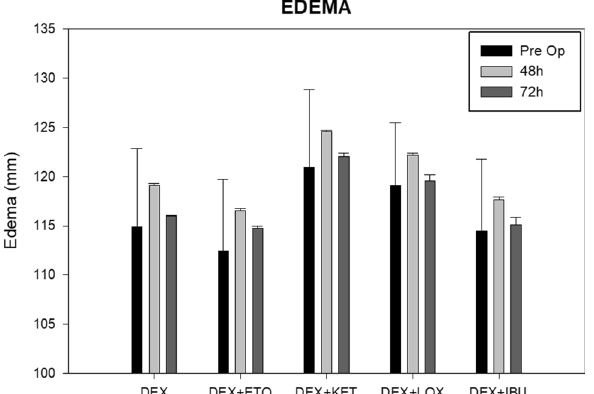
Figure 6. Chart regarding postoperative edema (mm). There was no statistical difference among the groups ( P > 0.05—Tukey test).